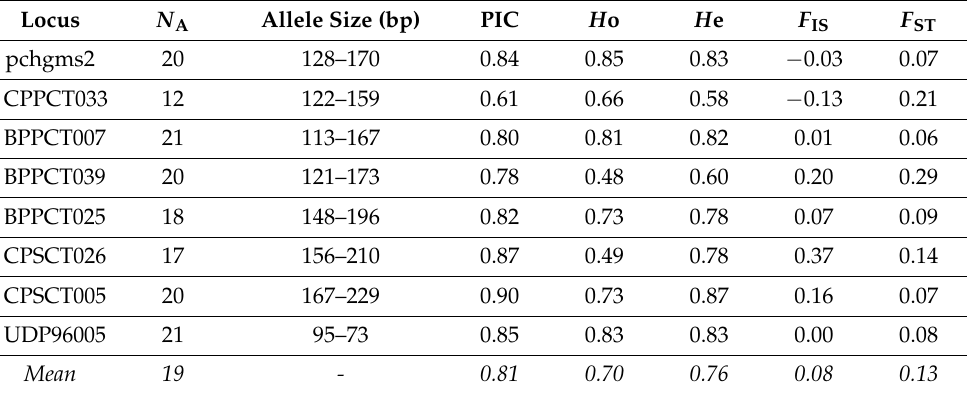
Table 1. Genetic diversity parameters of 115 accessions of interspecific plum × apricot hybrids and 27 reference genotypes using eight SSR markers. Number of alleles ( N A ), allele size, polymorphism information content (PIC), observed heterozygosity ( Ho ), expected heterozygosity ( He ), inbreeding coefficient ( F IS ), and Wright’s fixation index ( F ST